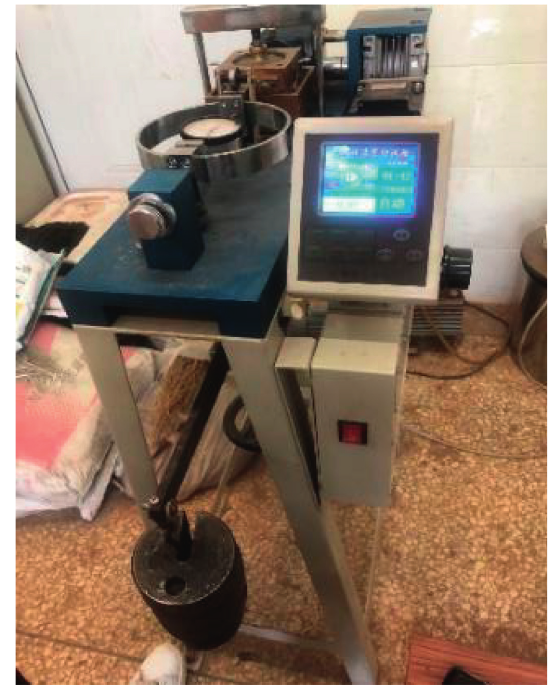
Figure 3: Direct shear